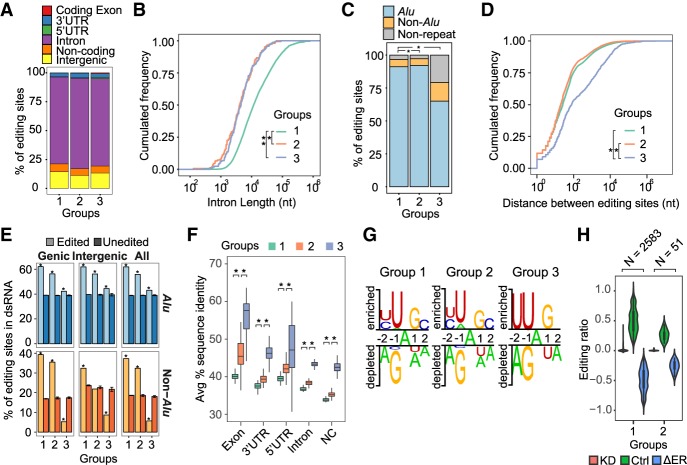
Characteristics of editing sites in different kinetic groups. (A) Genomic context of the editing sites. (B) Length of introns harboring editing sites: (*) P = 1.75 × 10−4 for group 1 versus 2; (**) P = 3.02 × 10−4 for group 1 versus 3 (Kolmogorov–Smirnov test). Groups 2 and 3 were not significantly different. (C) Presence of editing sites in Alus, non-Alu repeats, and nonrepeats: (*) P < 2.2 × 10−16 for group 1 versus 3 and group 2 versus 3 (Fisher's exact test). Groups 1 and 2 were not significantly different. (D) Closest distance (in nucleotides) between editing sites. For each editing site in a specific group, its closest neighboring editing site (regardless of group) was used to calculate this distance: (*) P = <2.2 × 10−16 for group 1 versus 3 and group 2 versus 3 (Kolmogorov–Smirnov test). Groups 1 and 2 were not significantly different. (E) Percentage of editing sites located in dsRNA structures predicted using BLASTN: (unedited) random As in the same type of genomic region as editing sites (Methods). Error bars represent 95% confidence interval based on 100 random trials; (*) P = <2.2 × 10−16 (Wilcoxon rank-sum test). (F) Average percent sequence identity across primates (Human, Chimp, Gorilla, Orangutan, Rhesus, Baboon, Marmoset, Tarsier, Mouse lemur, Bushbaby, and Tree shrew) calculated using the 46-way MULTIZ alignments (Kent et al. 2002). (NC) noncoding transcripts; (*) P < 2.2 × 10−16 (Wilcoxon rank-sum test). (G) Sequence consensus around the editing sites of each group, with the editing sites at position 0. Sequence motifs were identified via the Two Sample Logo program (Vacic et al. 2006). Random As that were in the same type of genomic region as editing sites were used as negative controls. (H) Editing ratios of groups 1 and 2 editing sites in U87MG ADAR1 knockdown (KD) and control (Ctrl) RNA-seq data (Bahn et al. 2012). The differences in editing ratios (ΔER) were calculated as (KD – Ctrl). The number of editing sites identifiable in the RNA-seq data is shown for each group (N).